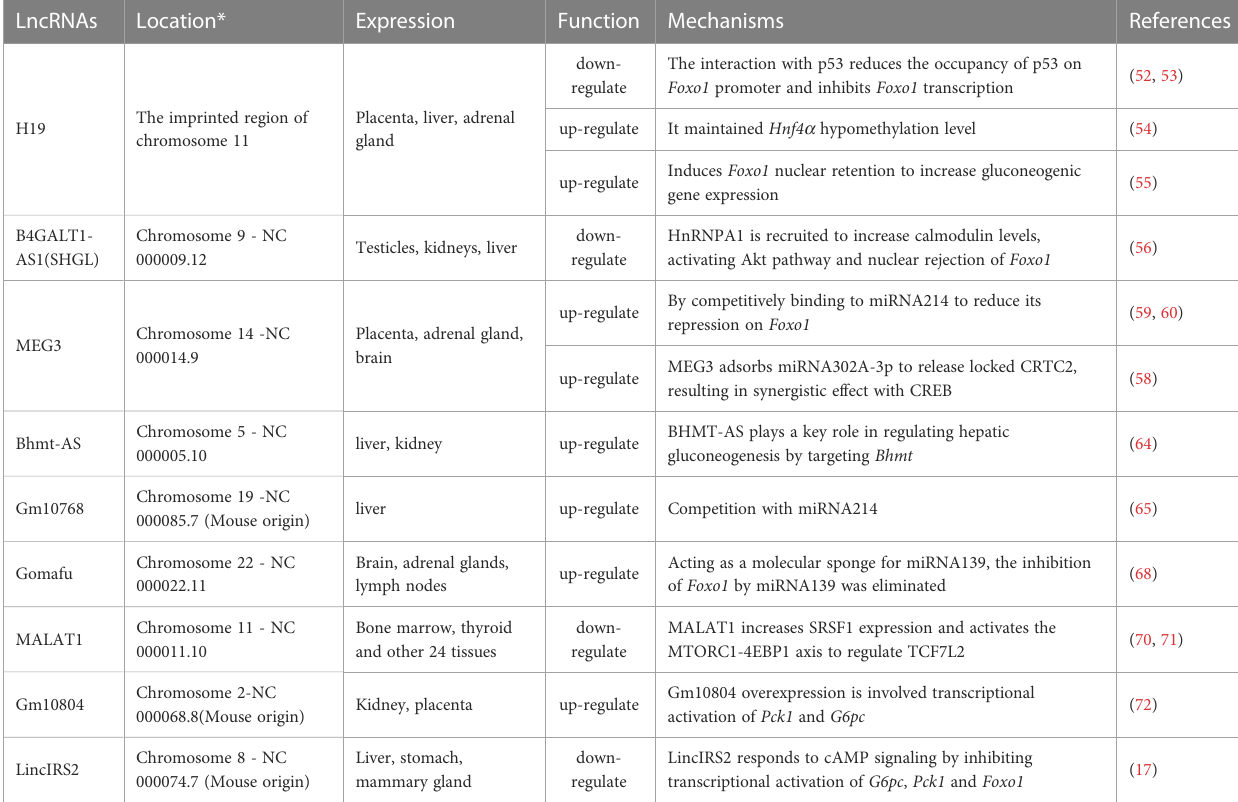
TABLE 1 LncRNAs involved in control of hepatic